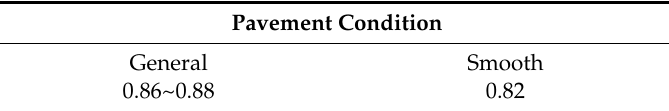
Table 1. Solar radiation absorption